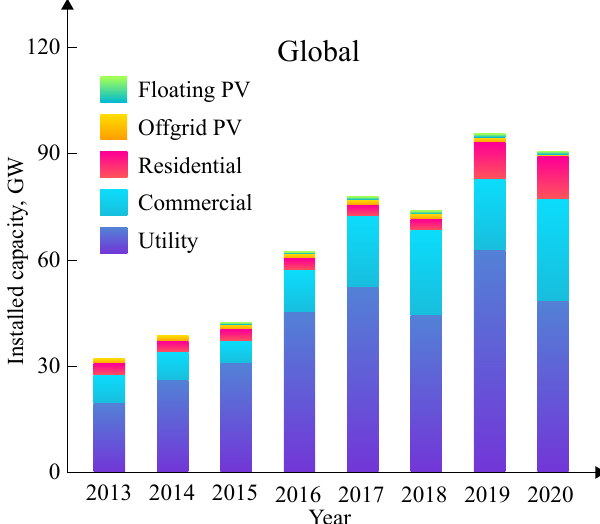
Figure 10. Global installed capacity of different solar applications. The utility-scale solar applications have the largest penetration, followed by commercial and residential deployments [3].